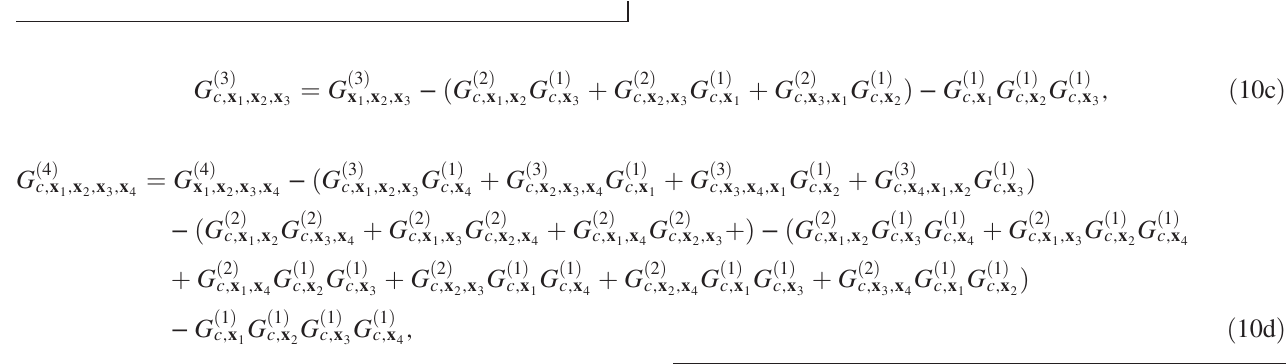
FIG. 1. Feynman diagrams relating full and connected corre- lation functions. At first order (a), the correlations are identical. At second order (b), there is one disconnected diagram that contains redundant information. At higher orders, an increasing number of disconnected diagrams need to be considered. We explicitly show the third-order (c) and fourth-order (d) correla- tions. The dots indicate permutations of the diagrammatic structure within the brackets, similar to